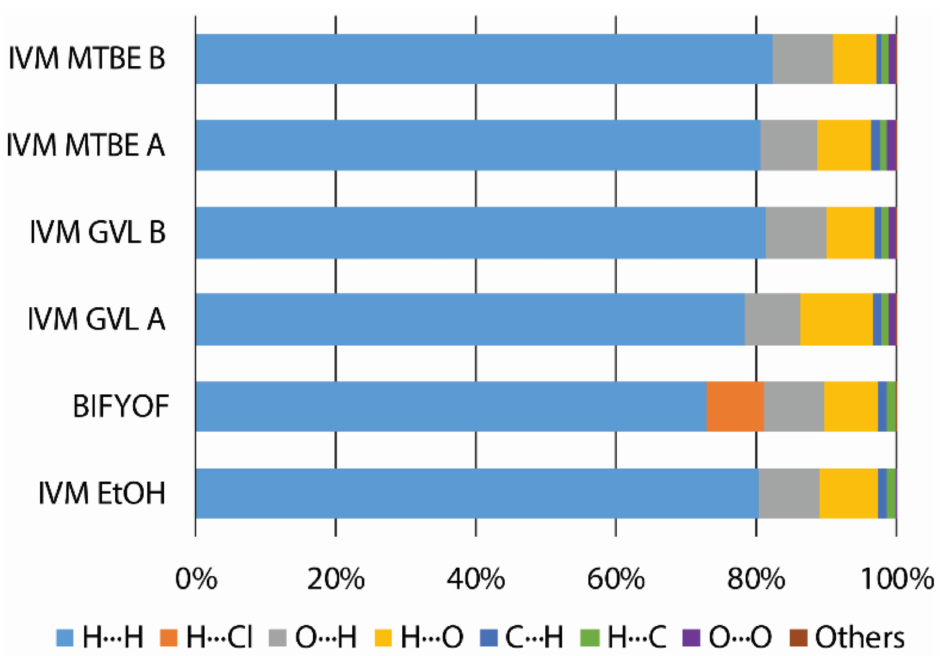
Figure 10. Percentage contributions of individual contacts to the Hirshfeld surface area for the analyzed IVM crystal